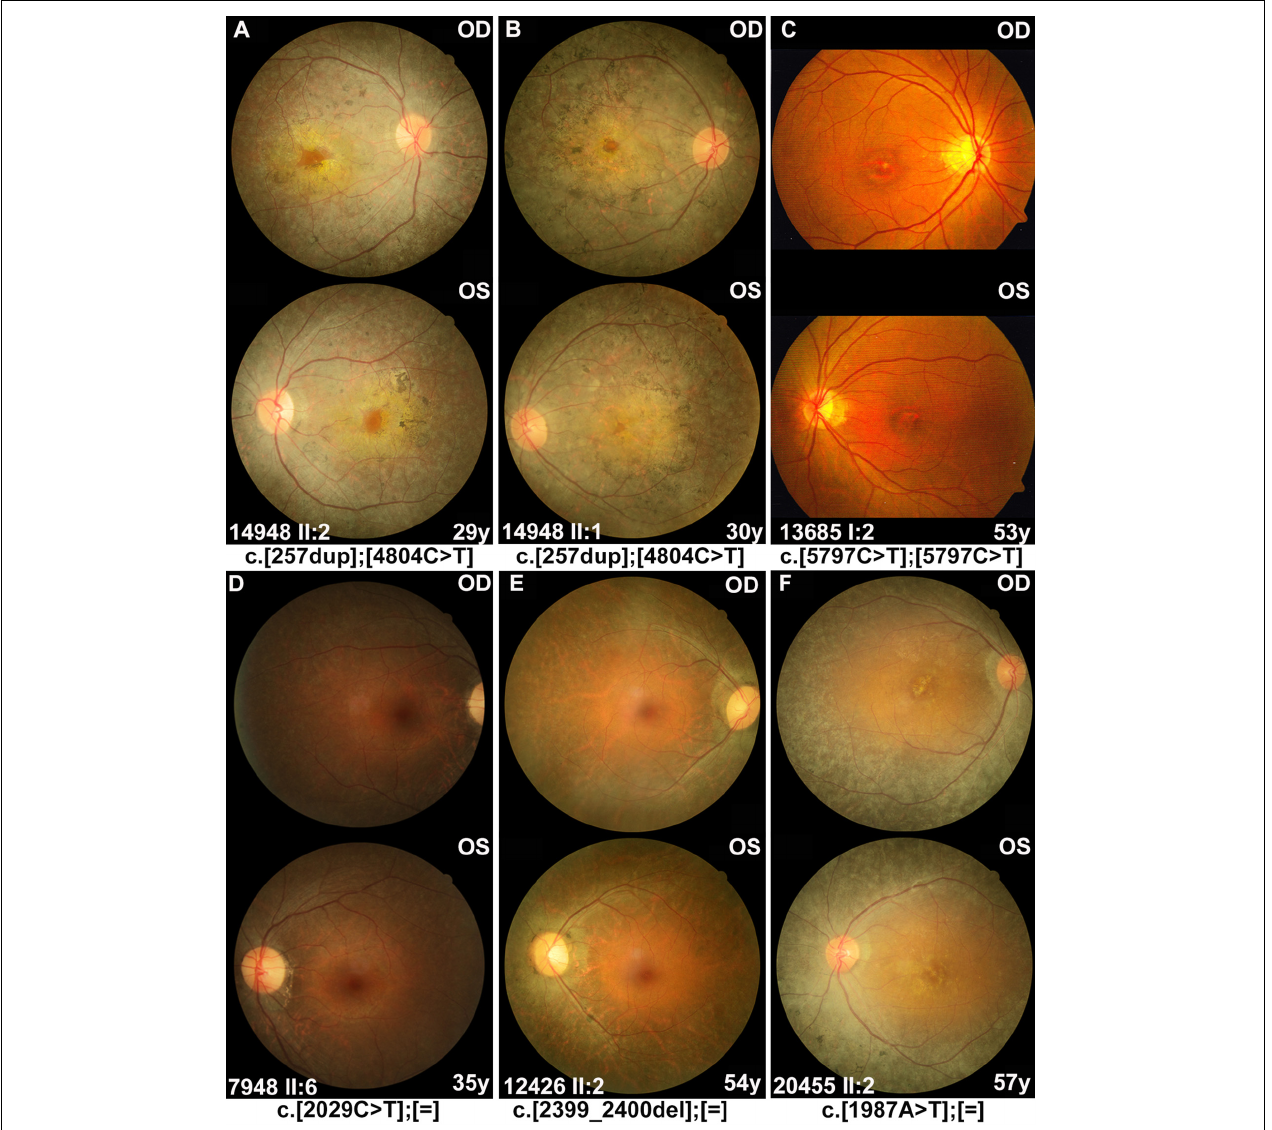
FIGURE 2 | Fundus photographs of the affected individuals with RP1 variants. (A,B) Severe phenotypes were shown in patients with biallelic RP1 variants, including waxy pale optic disc, attenuated vessels, and periphery degeneration with bone spicule pigmentation and involving macular region. (C) A 53 year-old patient diagnosed with macular degeneration rather than RP, who carried homozygous variant c.5797C > T (p.Arg1933*) in our cohort. (D–F) Patients with heterozygous RP1 variants were characterized by peripheral pigment disorders and scattered distribution of bone spicule pigmentation, both of which were often absent in the macular